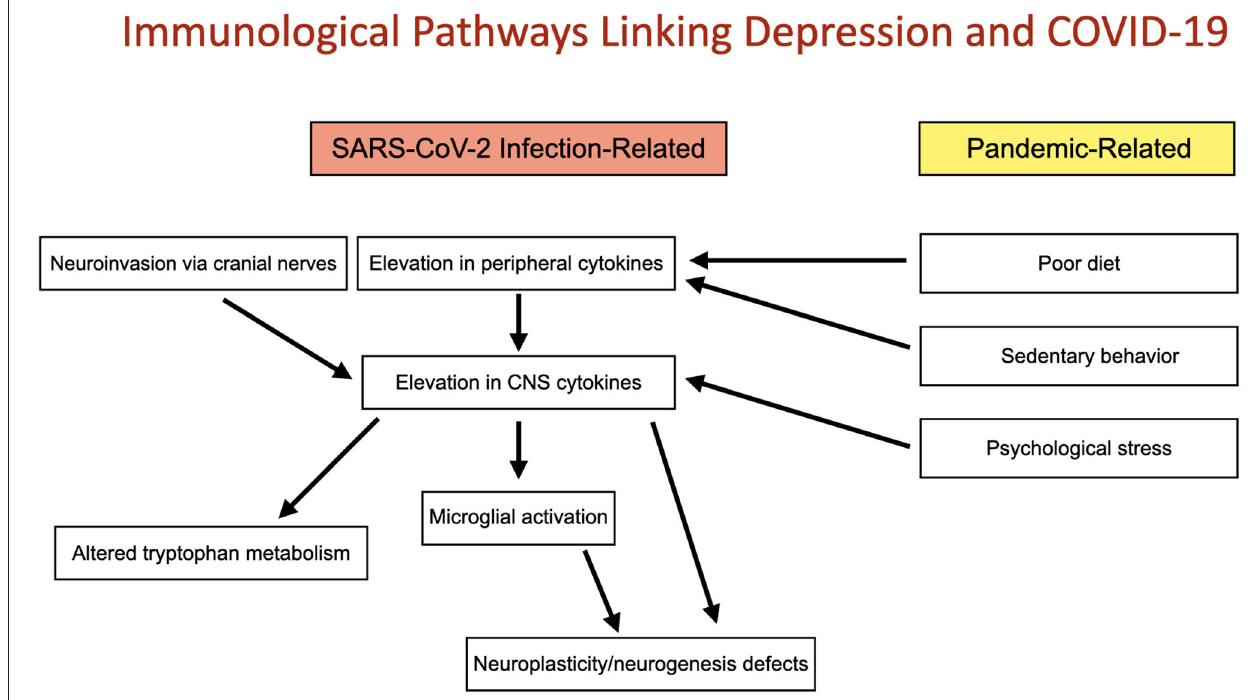
FIGURE 1 | Immunological pathways linking depression and COVID-19: Two convergent pathways connect the COVID-19 pandemic with altered immune function and depression. These include direct immunological implications of SARS-CoV-2 infection and indirect, non-infectious pandemic-related changes in immune function induced by poor diet, sedentary behavior and psychological stress. Both pathways may act to increase risk for depression by elevation of CNS cytokines and subsequently microglial activation, altered tryptophan metabolism and deficits in neuroplasticity and